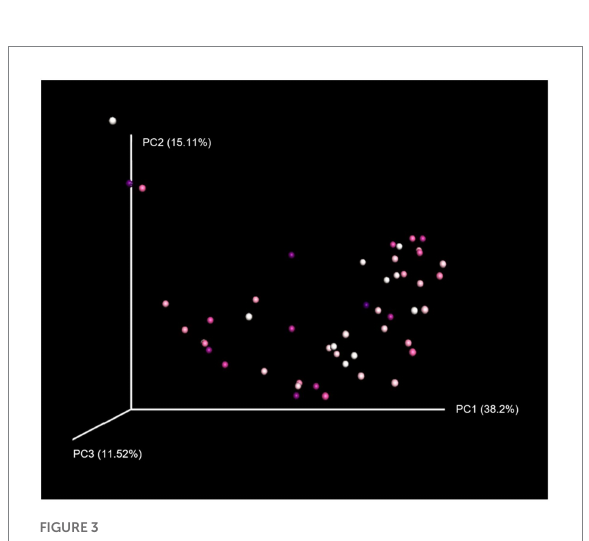
FIGURE 3 Principal coordinates analysis plot of microbiome composition using weighted UniFrac distances. Principal coordinates analysis reduces the dimensionality of microbiome data so that differences in microbiome composition between samples can be visualised, with points clustered together indicating more similar gut microbial communities. Points are coloured on a gradient from white (individuals receiving the least grooming) to dark purple (those receiving the most